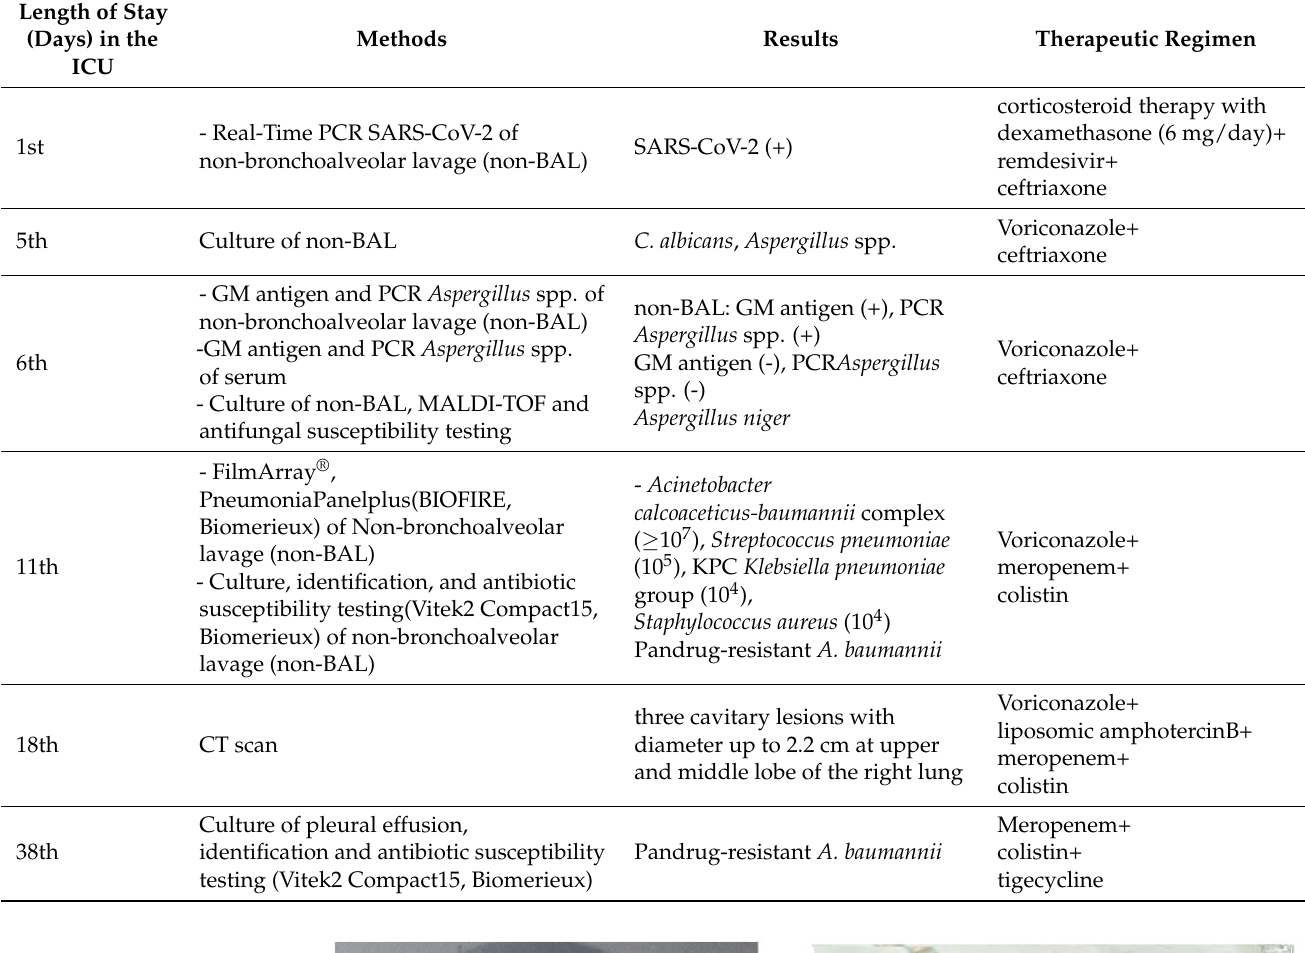
Table 1. Timeline of the methods, results and therapeutic regimens applied in the case study.